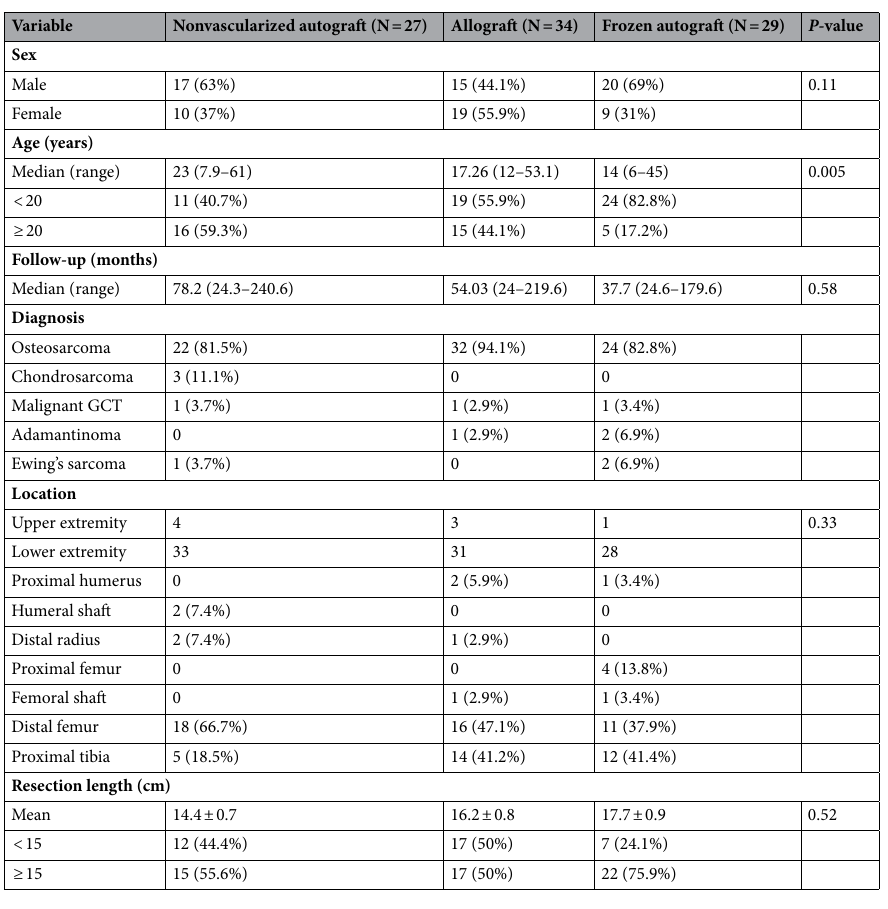
Table 1. Patient